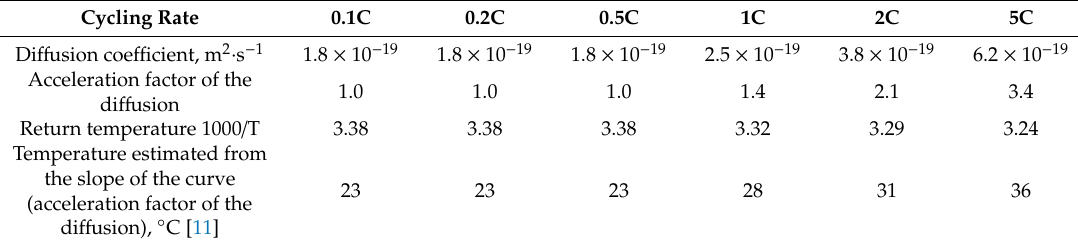
Table 3. Solid-state di ff usion coe ffi cient at di ff erent cycling